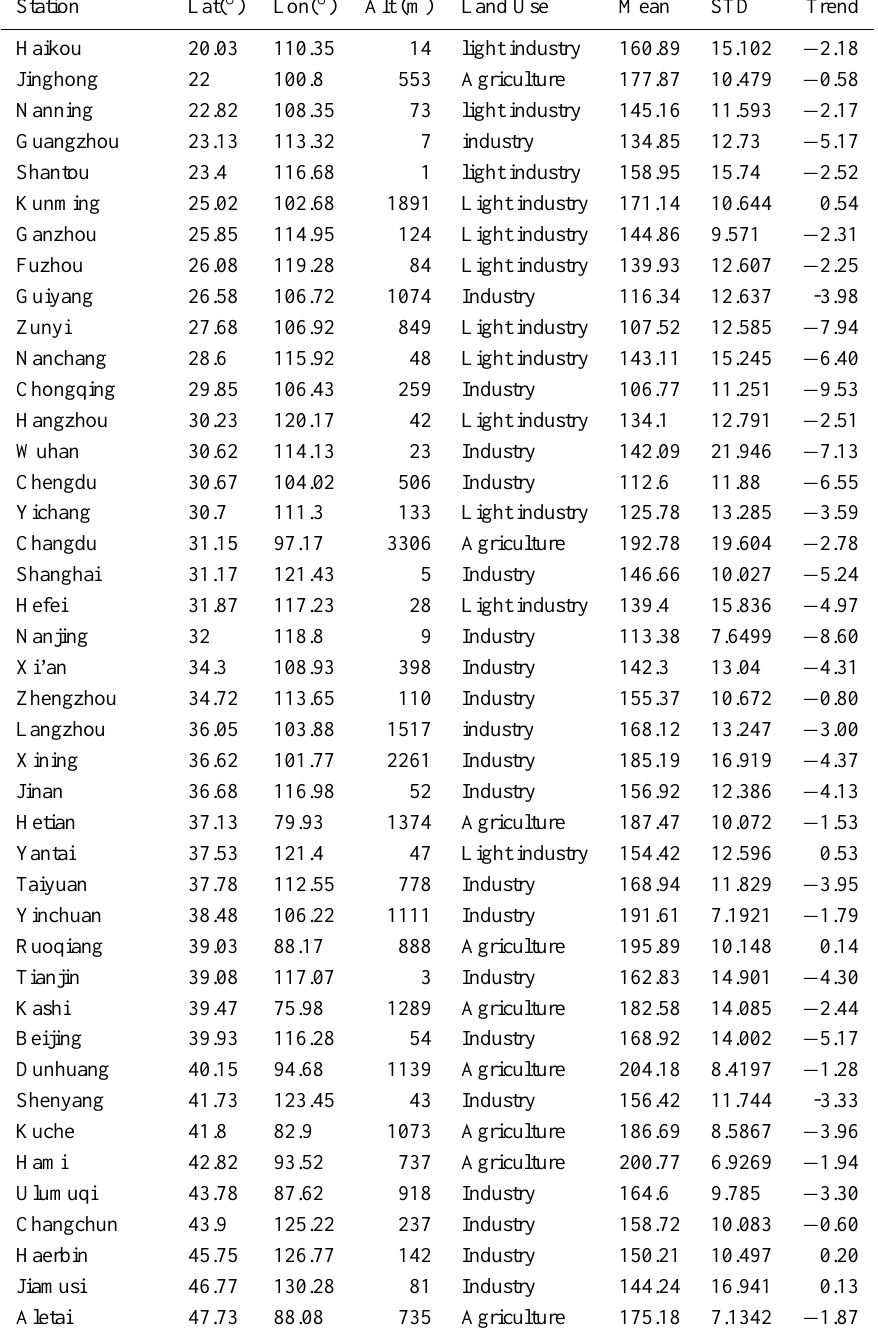
Table 1. Detailed description of 42 Chinese first-class pyranometer stations presented in the analysis. The title, location, altitude, land use, mean and one standard deviation of solar radiation (W/m 2 ) and its trend (% per decade) are given in each column,